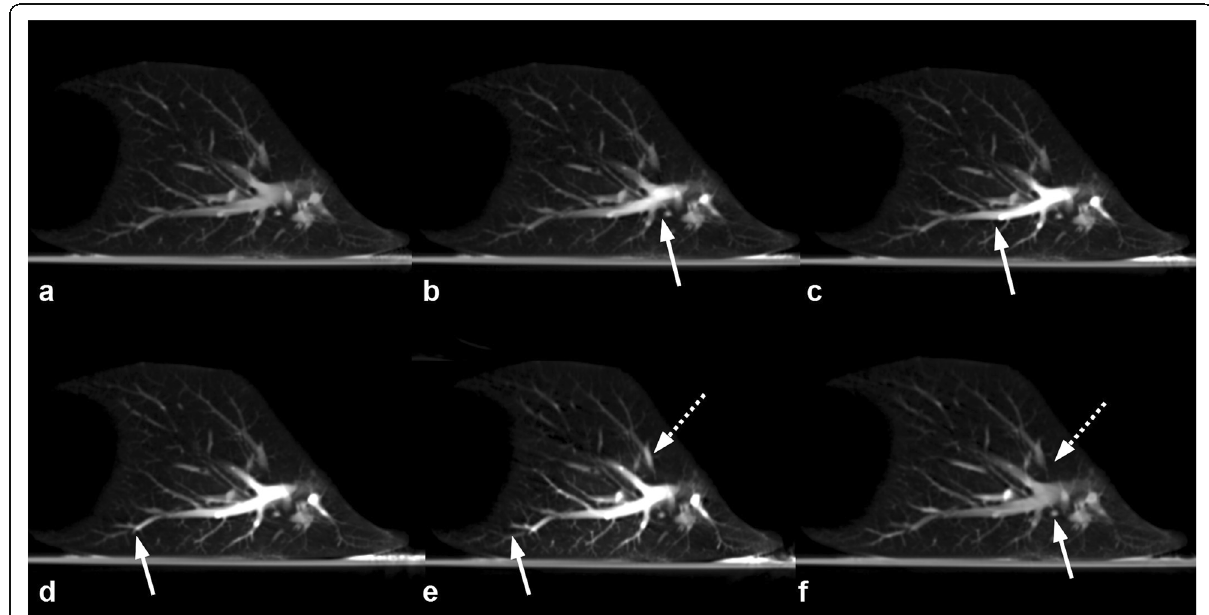
Fig. 5 Computed tomography perfusion imaging of case #3 at t30. While unenhanced pulmonary vessels can be observed prior to contrast media injection ( a ), a gradual filling of the arterial vessels can be observed (white arrow, from b to e ), followed by a filling of the pulmonary veins (dotted arrow in e ), and a complete washout of the contrast